Question: What does this figure show? Answer in one sentence.
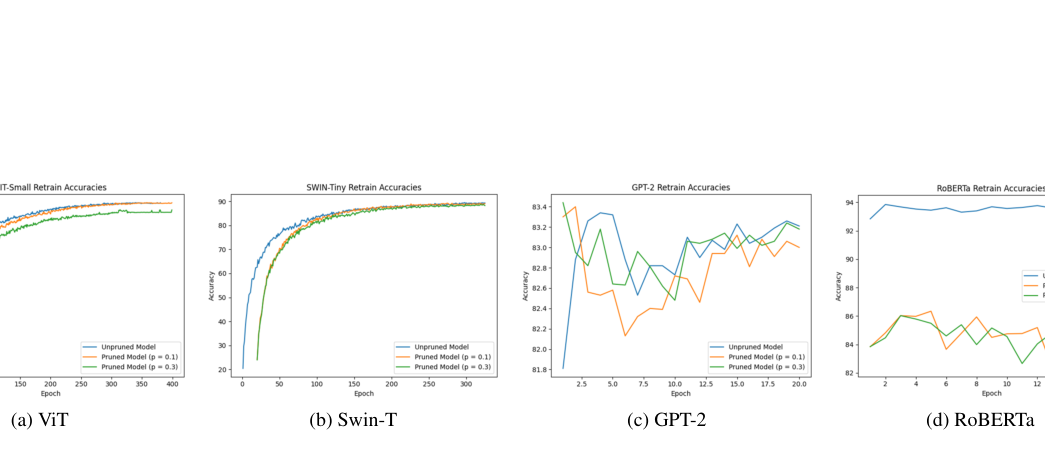
Answer: Accuracy plots for each model.